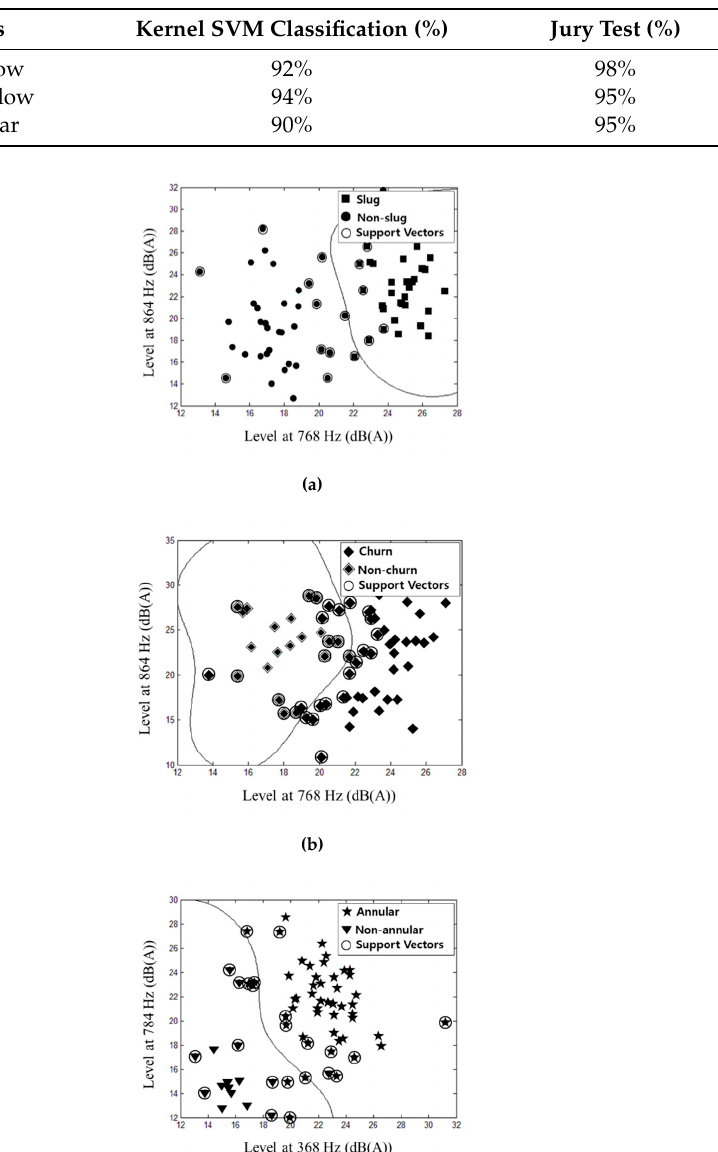
Table 10. Results of classification by kernel SVM and jury test.